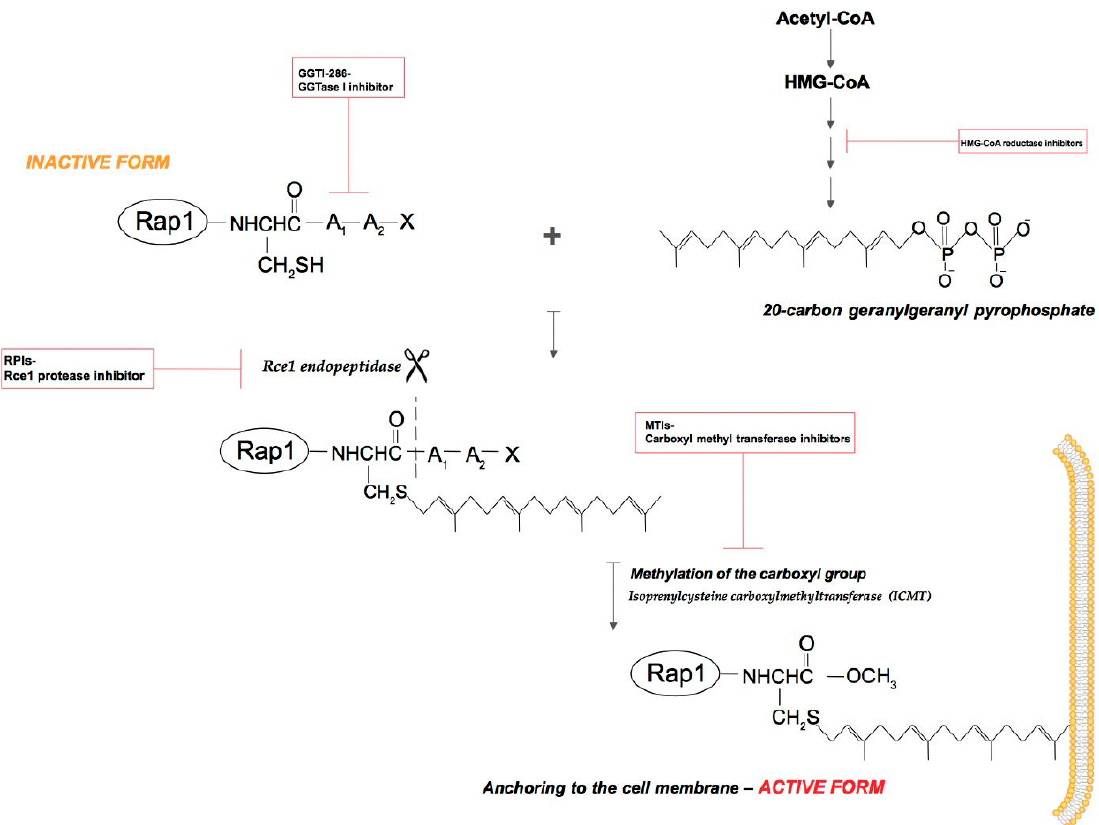
Figure 2. Rap1 GTPase isoprenylation. Rap1 post-translational modifications occurs in three steps. Step 1: the covalent attachment of a 20-carbon geranylgeranyl isoprenoid chain to the Cys residue in the CAAX (denoting the amino acid sequence Cys-aliphatic residue-aliphatic residue-X: usually Met, Ser, Gln or Leu) box located in the C-terminus (FTase and GGTase I but not GGTase II). Step 2: leavage off the three terminal amino acids via Rce1 endopeptidase (CAAX prenyl protease 2). Step 3: methylation of the isoprenylated Cys residue by the isoprenylcysteine carboxyl methyltransferase (ICMT) [13].